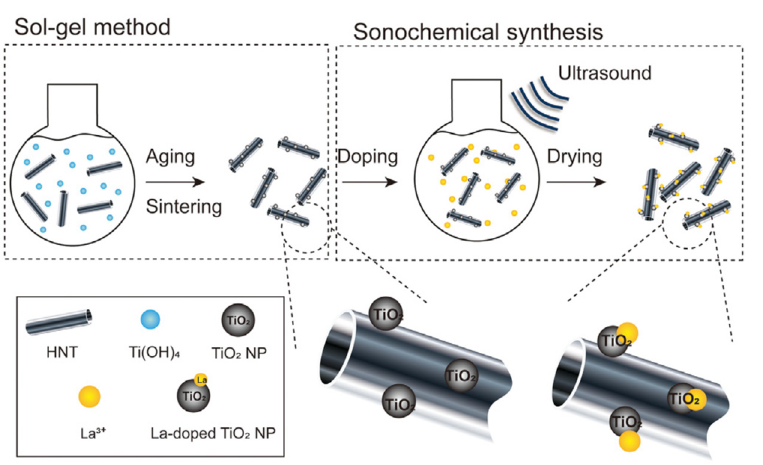
Figure 5. Synthesis of La/TiO 2 @HNTs nanomaterial. Reproduced with permission from ref. [79]. Copyright 2021